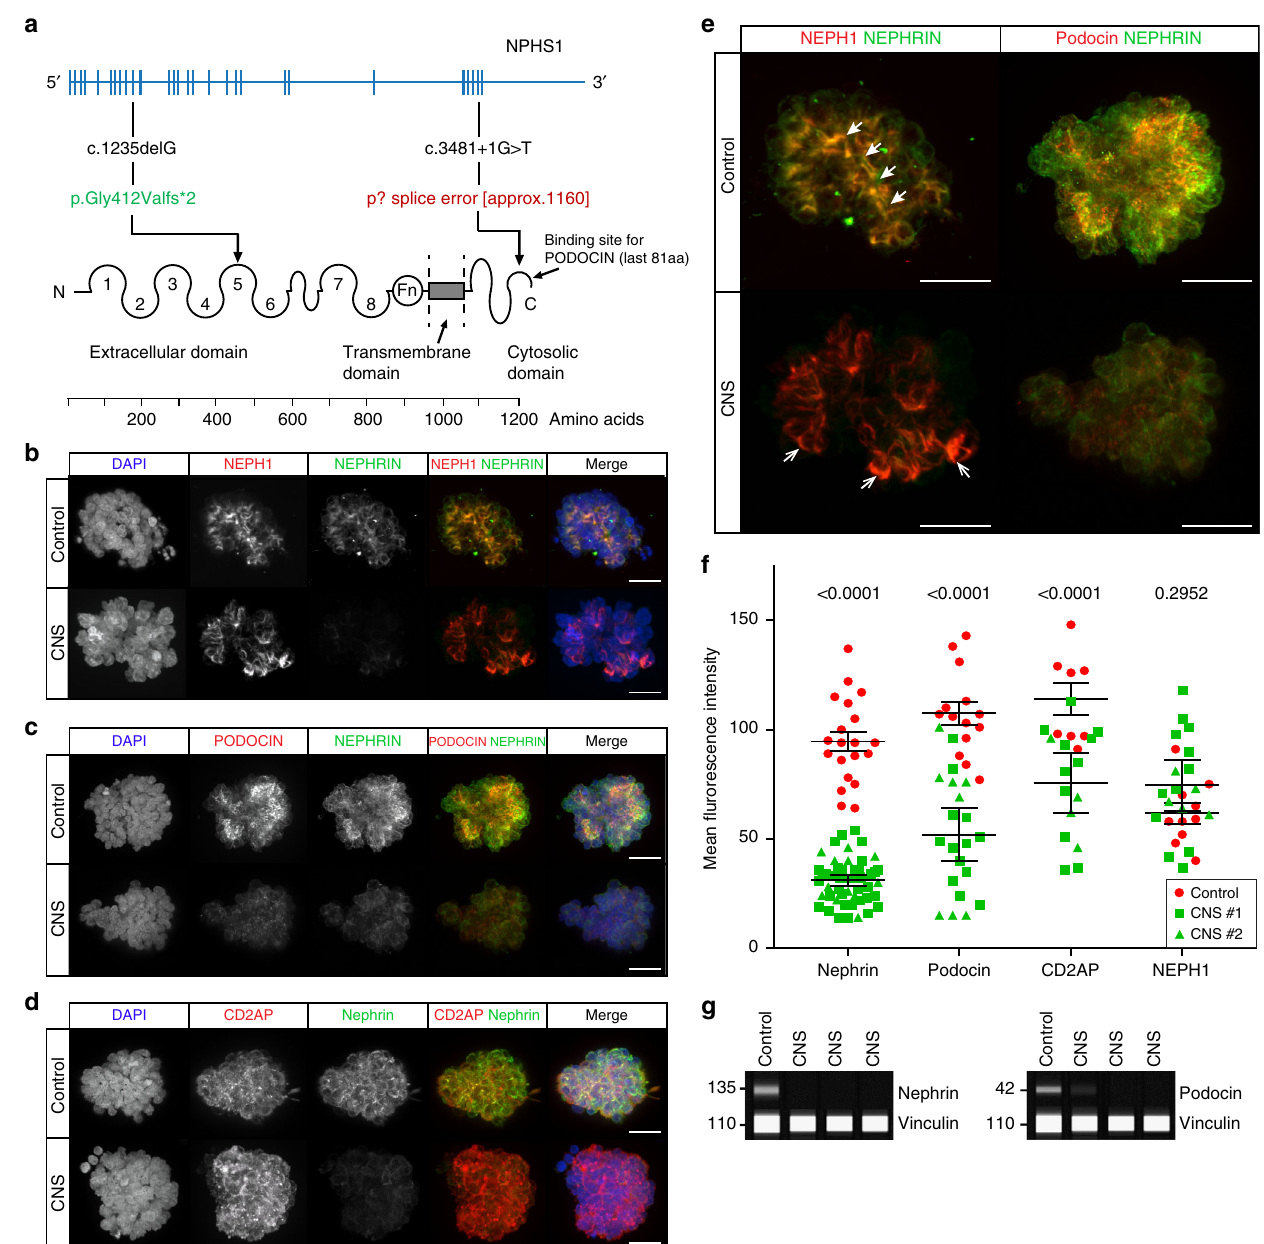
Fig. 6 Organoid Glomeruli model of congenital nephrotic syndrome in vitro. a Description of the NPHS1 variants identi fi ed in the patient modelled, diagnosed with congenital nephrotic syndrome (CNS). b – d Immunostaining of OrgGloms isolated from control organoids and CNS patient organoids show reduced NEPHRIN and PODOCIN protein levels in the organoids derived from patient-iPSC, representative images shown of >3 biological replicates. Scale bars 10 µ m. e Higher power immuno fl uorescent images show the polarised co-localisation of NEPHRIN with NEPH1 (solid white arrowheads) and PODOCIN in control OrgGloms. This polarisation is lost in CNS OrgGloms due to the absence of NEPHRIN (white arrows). Scale bars 10 µ m. f Quantitative analysis of fl uorescence intensities from independent OrgGlom biological replicates performed using one control and two distinct patient-derived CNS iPSC clones. Organoid glomeruli generated from both patient-derived iPSC clones show signi fi cant reduction in NEPHRIN and PODOCIN protein levels. Two-way ANOVA p < 0.0001; error bars = SEM. Biological replicates. NEPHRIN (controls, n = 20; CNS, n = 56); PODOCIN (controls, n = 14; CNS, n = 22); CD2AP (controls, n = 8; CNS, n = 15); NEPH1 (controls, n = 10; CNS, n = 17). Signi fi cant difference assessed by Sidak ’ s multiple comparisons test between cell lines; F -value = 112; DF = 1. NEPHRIN: control vs CNS#1, p < 0.0001; control vs CNS#2, p < 0.0001; CNS#1 vs CNS#2, p > 0.9999. PODOCIN: control vs CNS#1, p < 0.0001; control vs CNS#2, p < 0.0001; CNS#1 vs CNS#2, p = 0.9995. CD2AP: control vs CNS#1, p = 0.0007; control vs CNS#2, p = 0.0016; CNS#1 vs CNS#2, p = 0.9980. NEPH1: control vs CNS#1, p = 0.5320; control vs CNS#2, p = 0.9994; CNS#1 vs CNS#2, p = 0.9992. g Quantitative western blot analysis of NEPHRIN and PODOCIN protein levels within independent biological replicates con fi rms the signi fi cant depletion of these proteins in OrgGloms derived from CNS